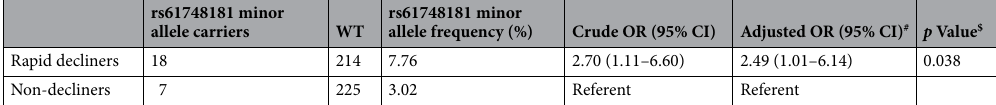
population growth kinetics of the TERT-expressing BJ cell lines followed typical logarithmic curves (Fig. 1B). While the BJ vector control cell line (BJ-vector), which does not express telomerase activity, entered replicative senescence following 10 PDLs post-antibiotic selection, all BJ fibroblasts expressing recombinant telomerase (WT/SNP variants) were proliferating continuously in our ex vivo cell model system. Using this ex vivo system,